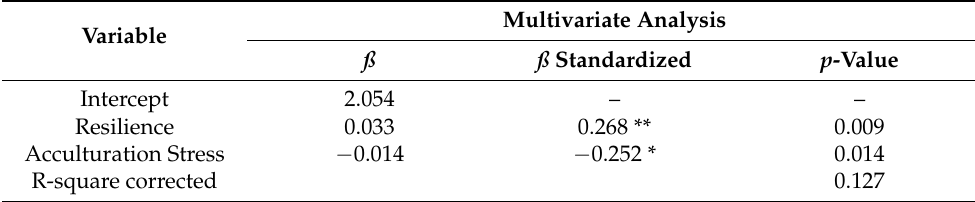
Table 4. Factors associated with integration and social competence in the primary sample.